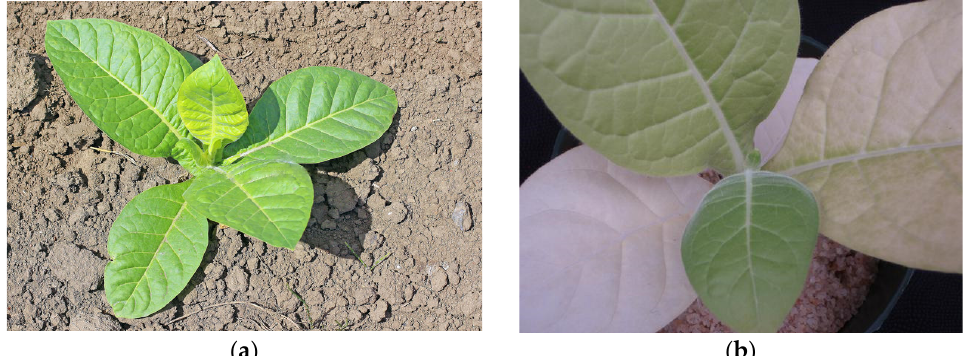
Figure 2. Tobacco plant: ( a ) Healthy tobacco sprout without nitrogen (N) deficiency; ( b ) tobacco with N deficiency [17].